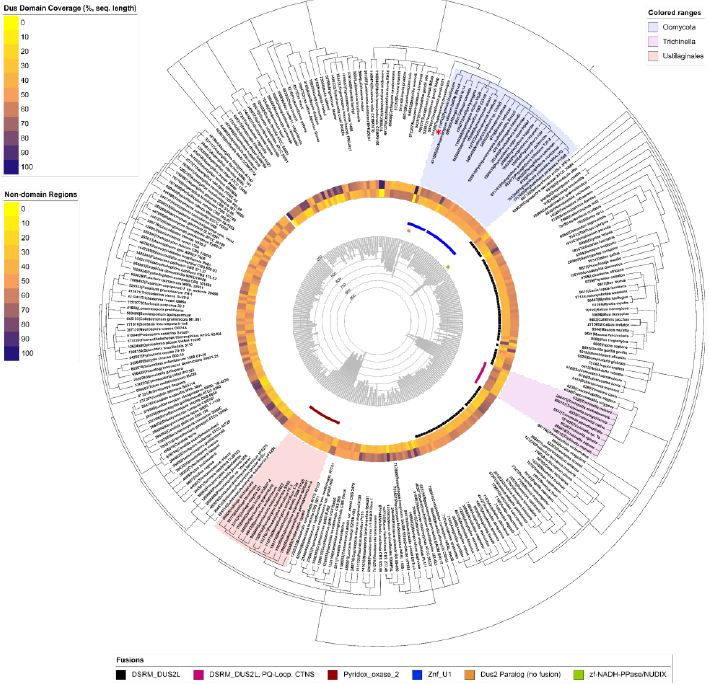
Figure 3. Phylogenetic tree of 280 Dus2 family members illustrating domain architecture diversity. Moving from the inside of the figure to the outside: (1) Sequence lengths are denoted by the central histogram; (2) Colored bars (one square per organism) indicate the presence of distinct fusion proteins (note: given multiple squares for one organism, they indicate the instance of separately encoded homologs); (3) Percent coverage of sequences for both the remaining lengths not identified as belonging to any recognizable domain (inside) and the identified Dus domain (outside) are shown. A red asterisk among the labels of the tree’s leaves denotes the zinc finger domain-containing homolog of Pythium insidiosum that, in addition to ZnD_U1, also contains a separate ICL_KPHMT fusion